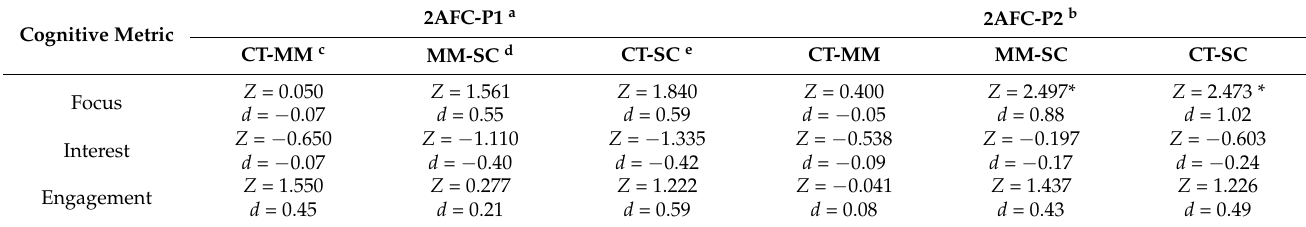
Table 5. Comparative of cognitive metrics between groups.